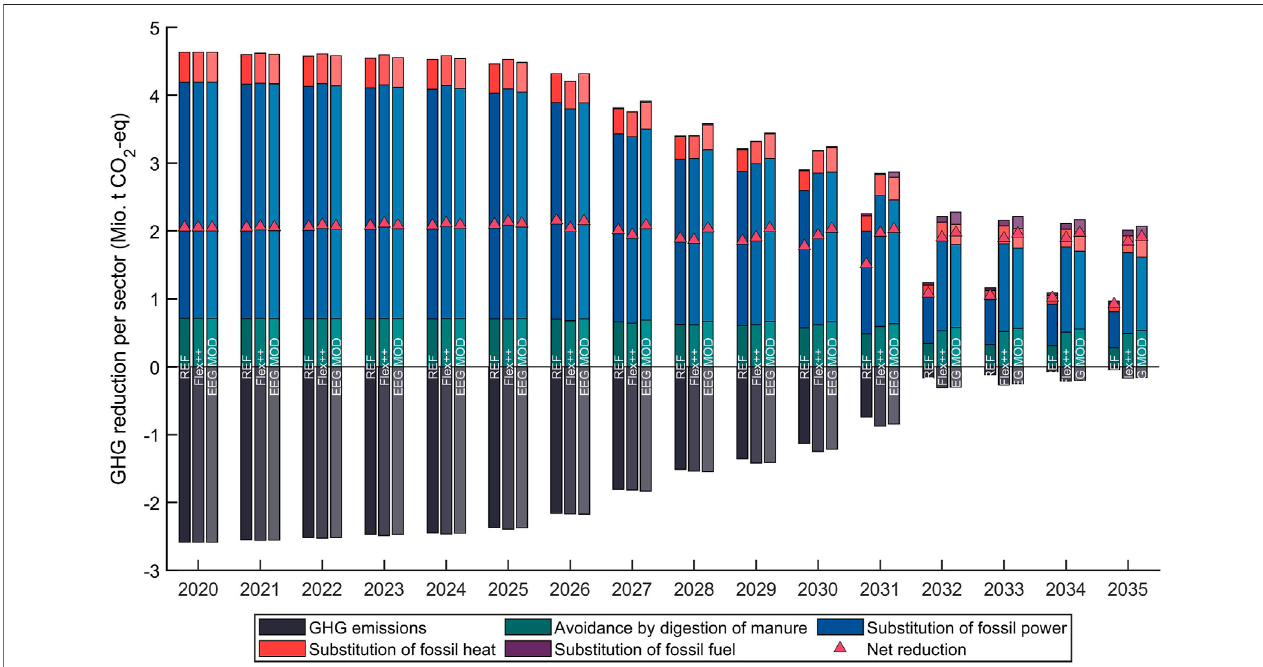
FIGURE 8 | Development of greenhouse gas(GHG) emission reduction by all existing BGP until 2035 in all three regions ( n (cid:1) 2,508) comparing all three scenarios. Showing sector-wise shares of GHG emission avoidance, GHG emissions of biogas production, and the resulting net reduction.